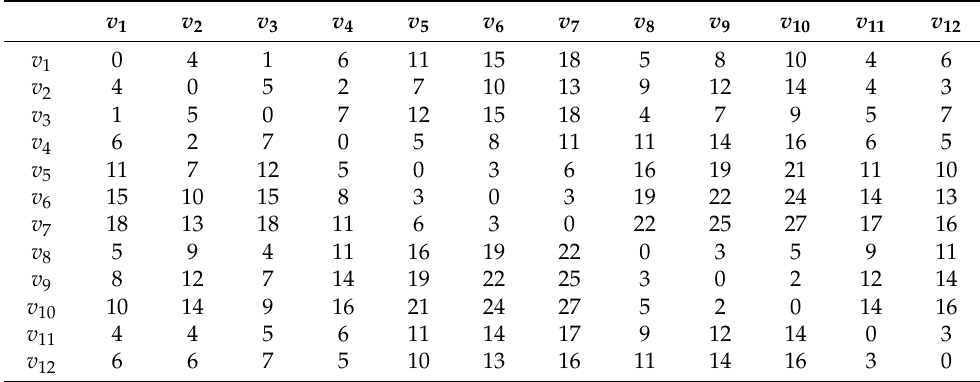
Figure 4. Schematic diagram of the customized shuttle bus routes planning. Table 2. Distance matrix among stops